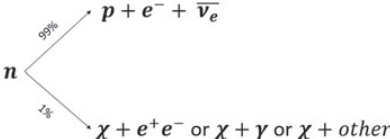
Figure 1. Simple decay diagram of the free neutron including a proposed dark decay channel. χ here represents a dark sector particle. ‘Others’ refer to decay channels involving a dark sector fermion [5].